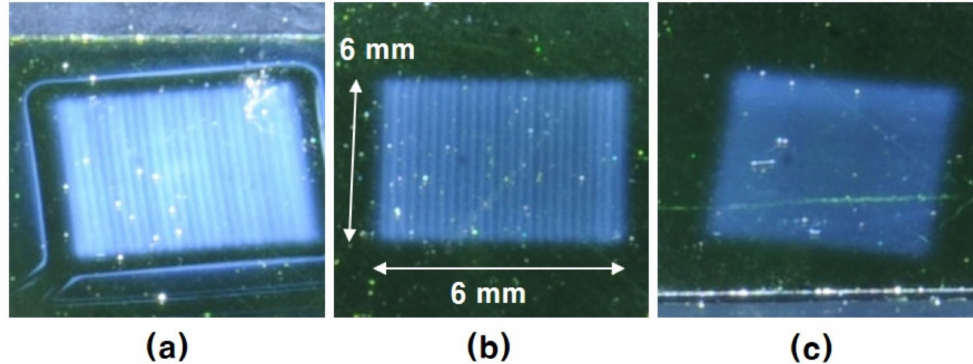
Figure 5. Haze on the specimen surface that remained after five times repeated etching of a 6 mm by 6 mm raster scan etch by the mixed gas filament plasma of He 2 slm and NF3 ( a ) 0.5 sccm, ( b ) 1 sccm and ( c ) 2 sccm. (Va: 1